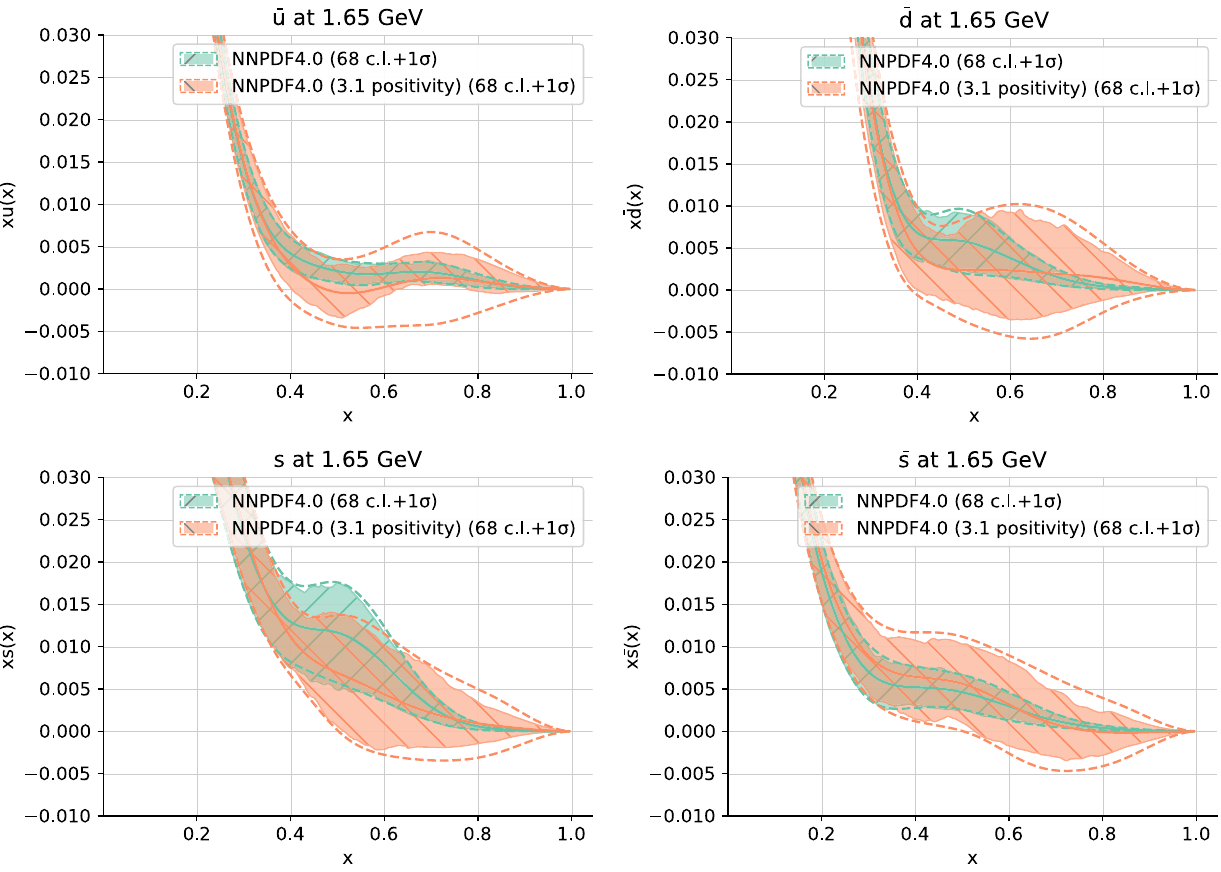
Fig. 47 Comparison to the baseline NNPDF4.0 fit of the PDFs determined by removing the new PDF positivity constraints, and hence using only theNNPDF3.1positivityconditions.Theantiup,antidown,strangeandantistrangePDFsareshownattheinputparametrizationscale Q = 1 . 65GeV